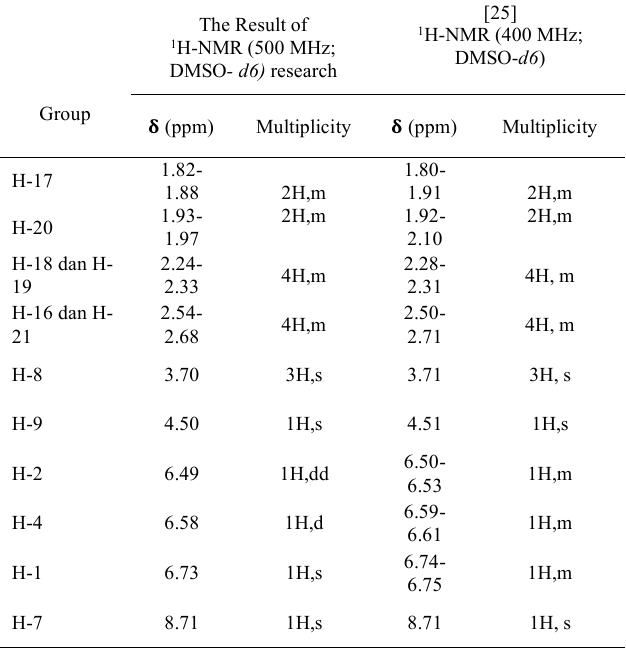
Table 3. 1H-NMR of Synthesized Product Interpretation and Previous Study's Interpretation